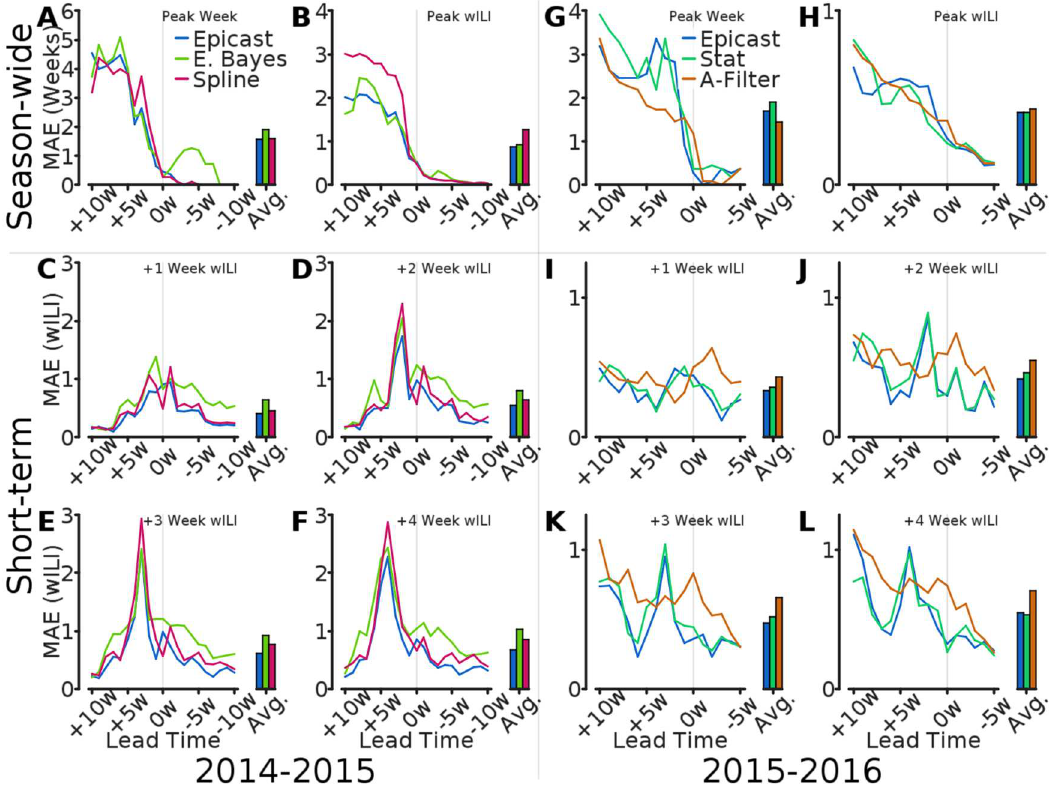
Fig 6. Comparison of mean absolute error by lead time. Mean absoluteerror across regions( n = 11) is plotted as a function of lead time for of Epicast, Empirical Bayes (E. Bayes), PinnedSpline (Spline),Stat, and ArcheFilter (A-Filter). MAE averagedover lead times is shown for each method on the right side of each subplot. Subplots show MAE in (A; G) Peak Week, (B; H) Peak Height, and (C–F; I–L) wILI at 1, 2, 3, and 4 weeks